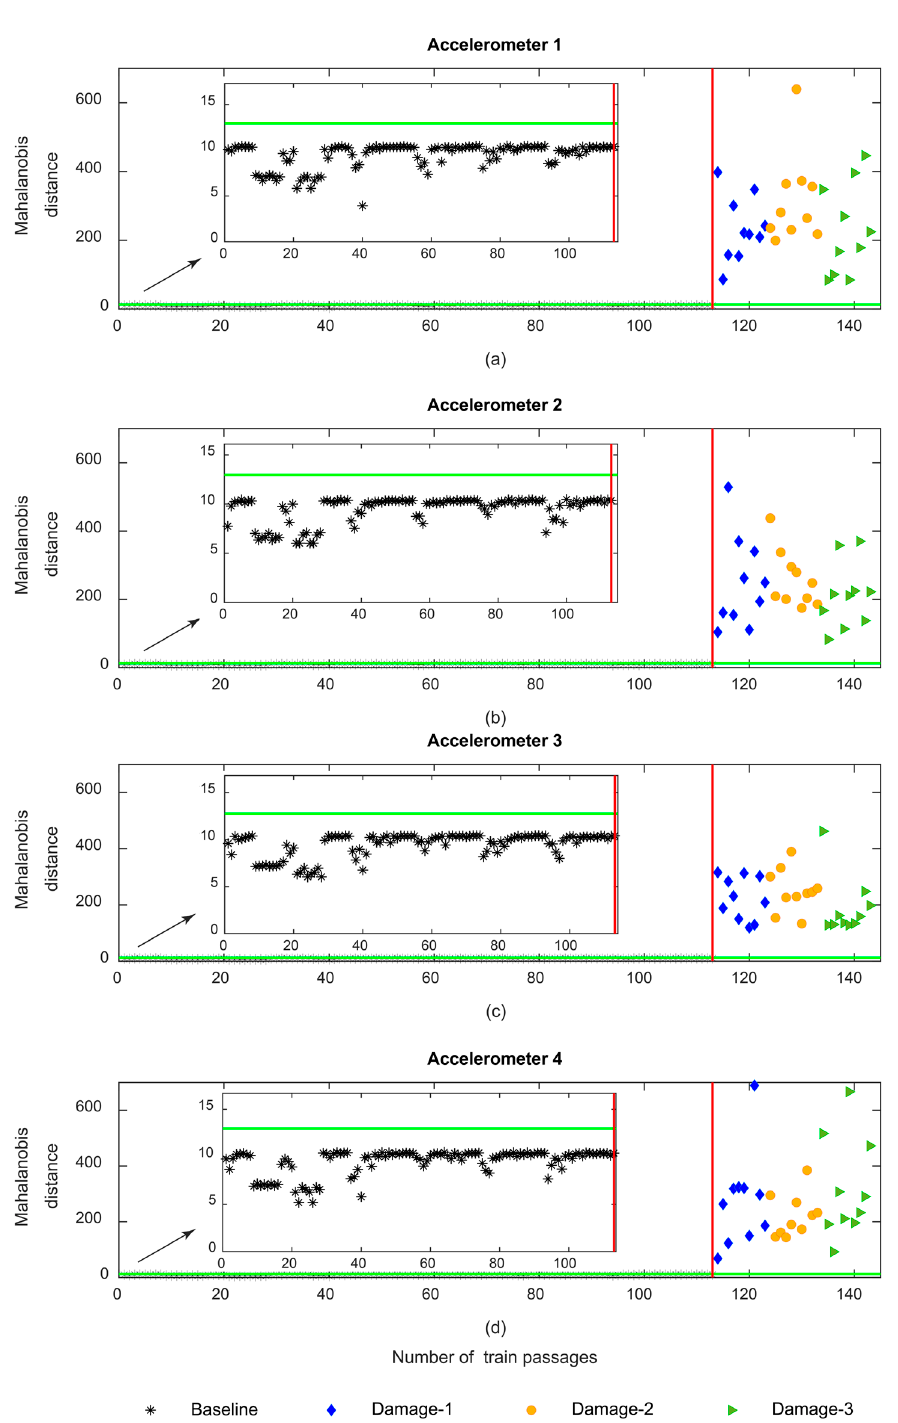
Figure 22. CWT—automatic wheel flat damage detection considering the responses from accelerom- eters 1–4: ( a ) MD for accelerometer 1, ( b ) MD for accelerometer 2, ( c ) MD for accelerometer 3, ( d ) MD for accelerometer 4.